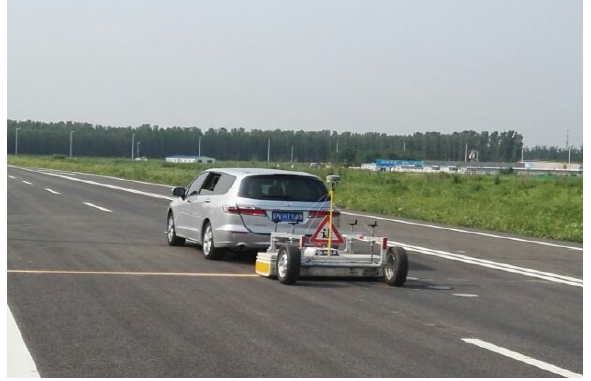
Figure 13. The MIRA.